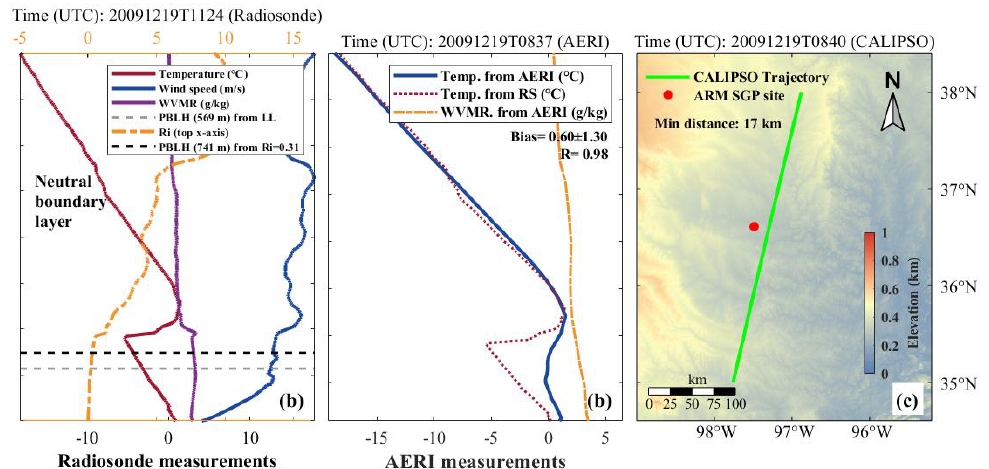
Figure 10. PBLHs were determined using the ( a ) radiosonde (RS) at 11:24 and ( b ) AERI at 08:36 on 19 December 2009 (UTC, nighttime); ( c ) ARM SGP site of radiosonde observations and CALIPSO trajectory. The minimum distance between the CALIOP and radiosonde (AERI) measurements is shown at the top of subfigure ( c ).